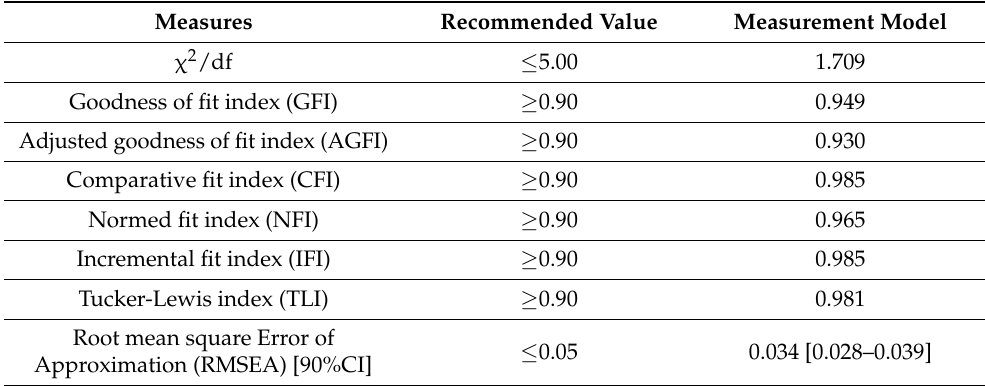
Table 5. Evaluation of model